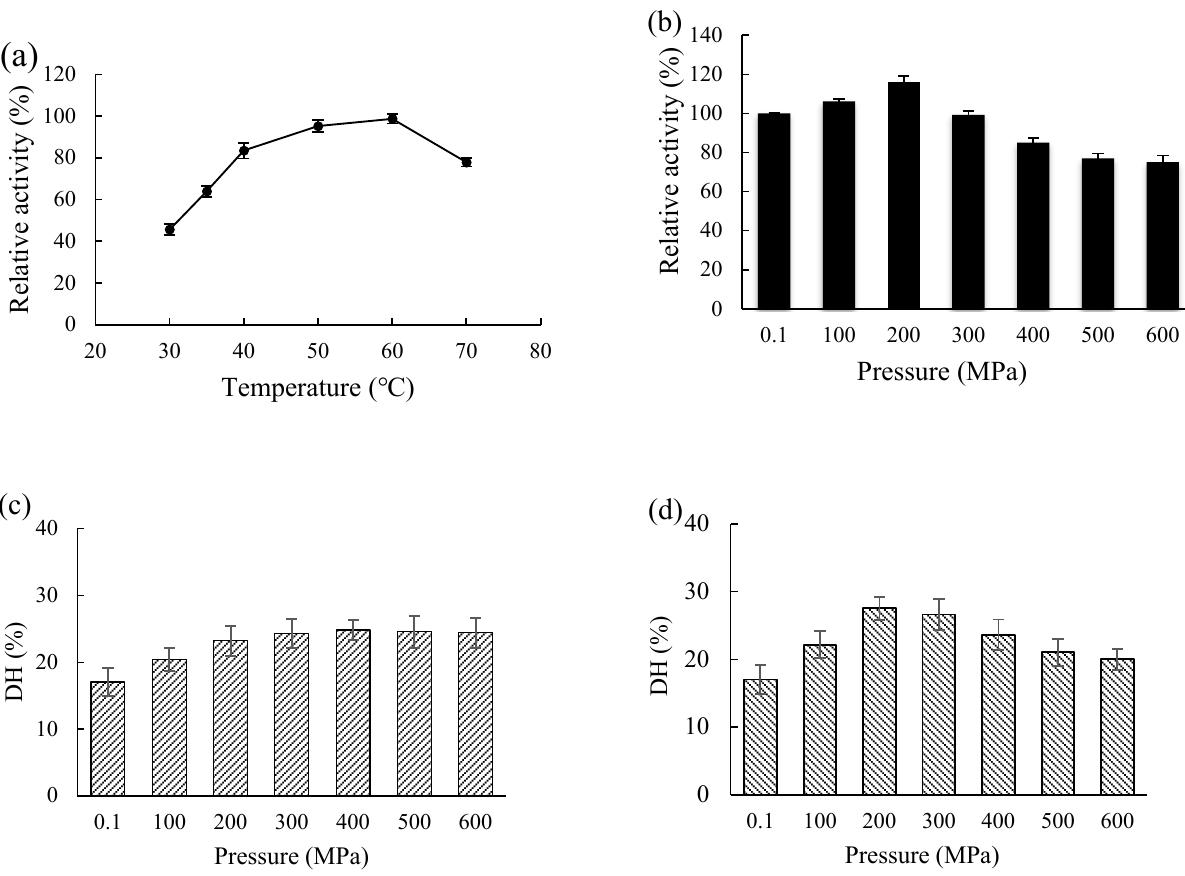
Figure 3. Effects of temperature and HHP on the activity of papain. ( a , b ) The DH of b-LG by papain in case of different high-pressure treatments, ( c ) The hydrolysis of b-LG at 60 °C after high-pressure pretreatment, and ( d ) The hydrolysis of b-LG under different high pressures at 60 °C.